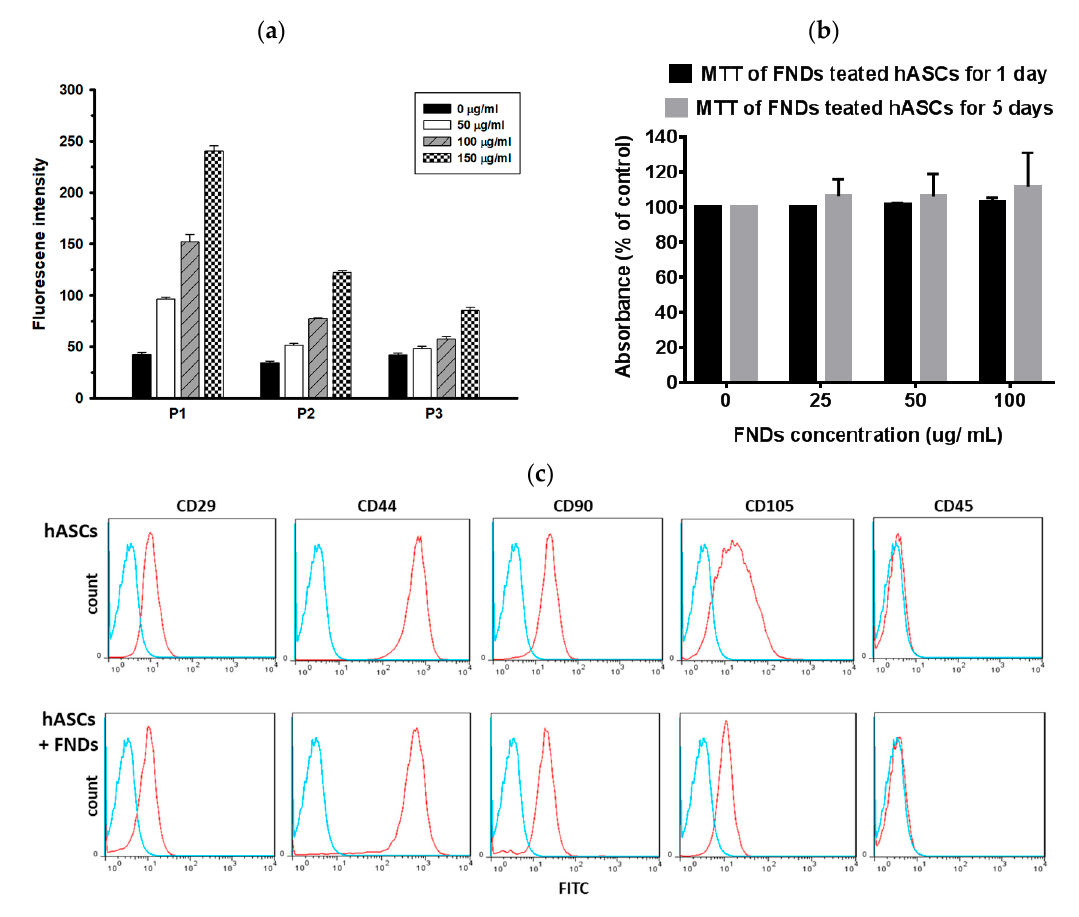
Figure 3. ( a ) Fluorescence intensity of FND-labeled hASCs was detected after each passage. 1 × 10 5 hASCs were labeled with FNDs (0, 50, 100, 150 µ g / mL). Values are means ± S.E.M. from three independent experiments. Data were assessed using one-way ANOVA, followed by Turkey’s multiple comparison tests. ( b ) 1 × 10 5 hASCs were treated with FNDs (0, 25, 50, 100 µ g / mL) for one and five days, followed by MTT analysis. Values represent the means ± S.D. of three independent experiments. Data were assessed using T tests. ( c ) Surface markers of hASCs. Representative flow cytometry analysis demonstrated positives for mesenchymal stem / stromal cells markers CD29, CD44, CD90, and CD105, but negative for CD45. Blue lines indicate the isotype control. FITC-A, fluorescein isothiocyanate area.